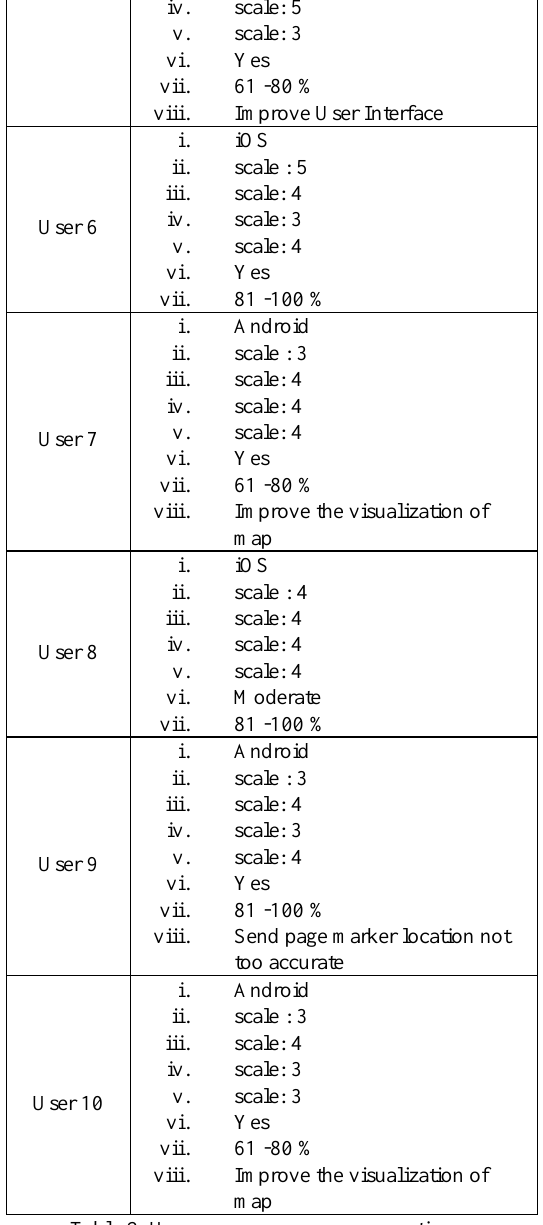
Table 2. User response on survey